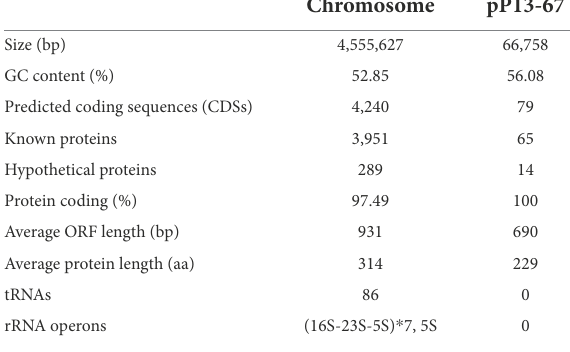
TABLE 2 General features of the L.amnigena P13